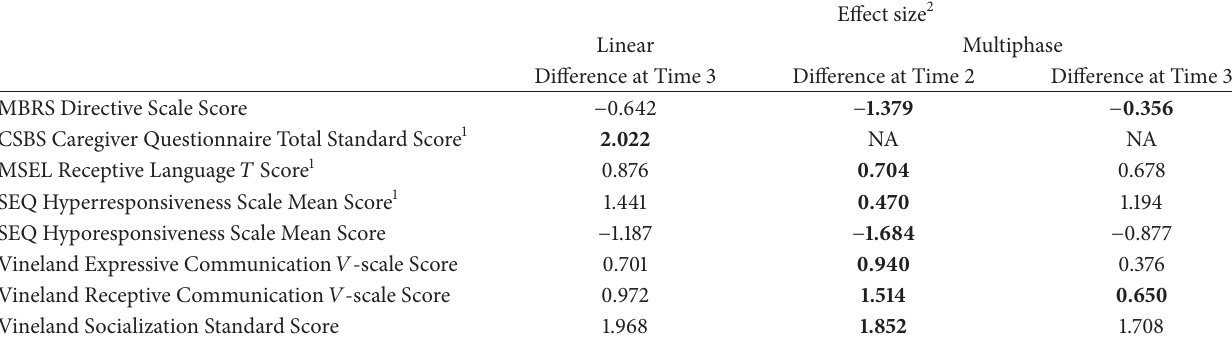
Table 5: Effect sizes from linear and multiphase growth models with statistically significant